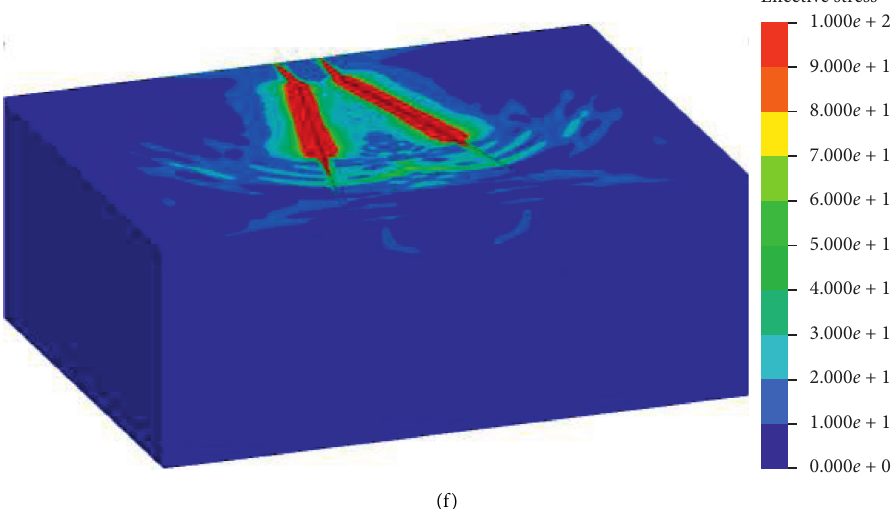
Figure 5: Effective stress wave evolution of cut blasting model for a small charge diameter. (a) t � 045 μ s; (b) t � 150 μ s; (c) t � 320 μ